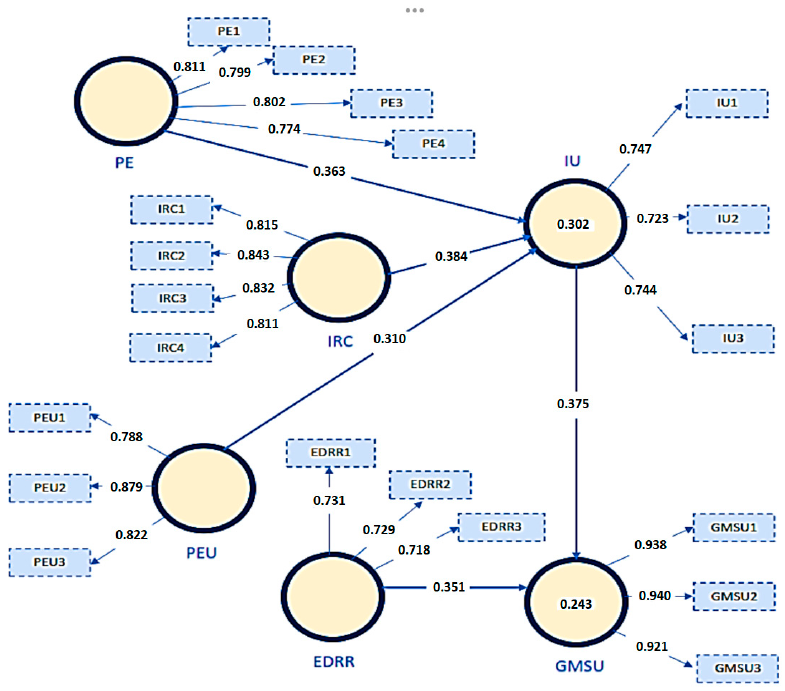
Figure 6. Analysis of the causal relationship in the structural equation model.